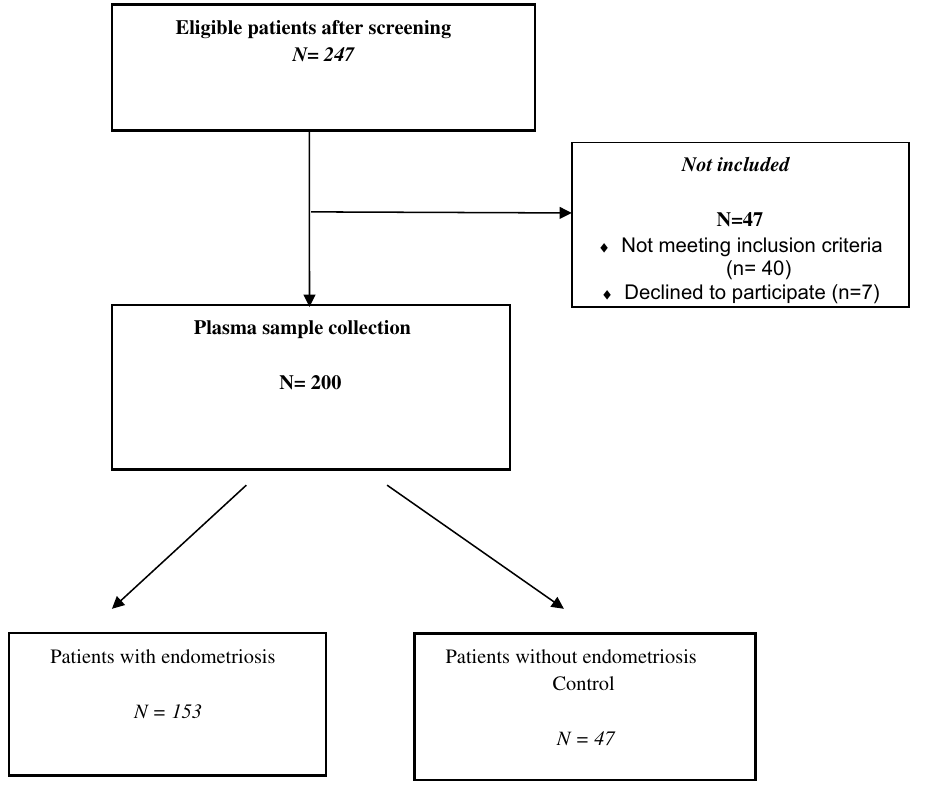
Figure 1. Flow chart of the ENDO-miRNA